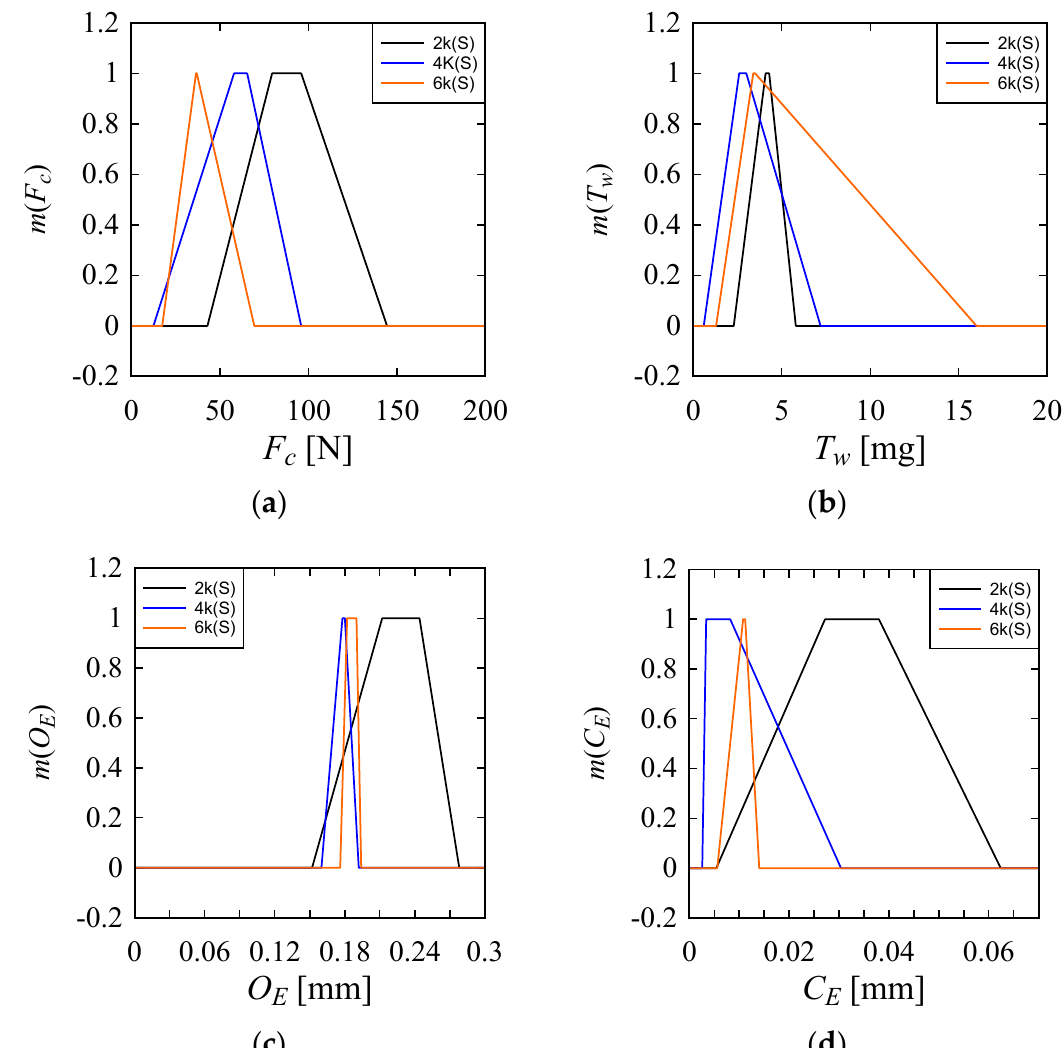
Figure 7. Effect of spindle speed on the performance parameters ( a ) On Cutting Force ( F C ); ( b ) On Tool Wear ( T W ); ( c ) On Over Cut Error ( O E ); ( d ) On Cylindricity Error ( C E ).